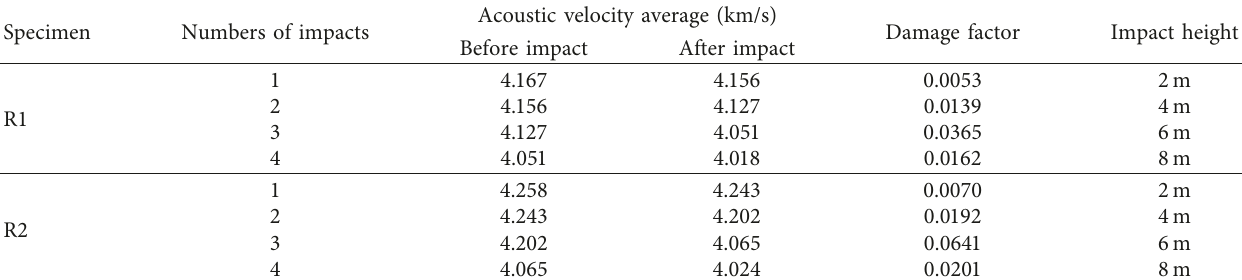
Figure 5: Impact force history of the R2. Table 3: Damage factor changes under continuous